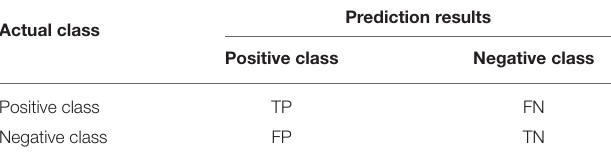
TABLE 4 | Confusion